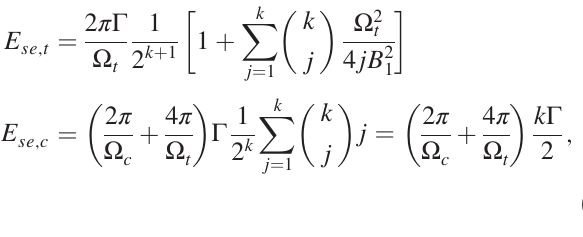
where Γ ≃ 1 kHz at T ¼ 77 K is the maximum decay rate of the applied Rydberg levels with n ≃ 100 . During population rotation between the ground and Rydberg levels, another error of magnitude ½ð j − 1 Þ 2 D 2 cc = Ω 2 c (cid:2) appears for each control atom due to the unwanted interaction D cc ¼ ð C mm 6 =r 6 cc Þ between the control atoms